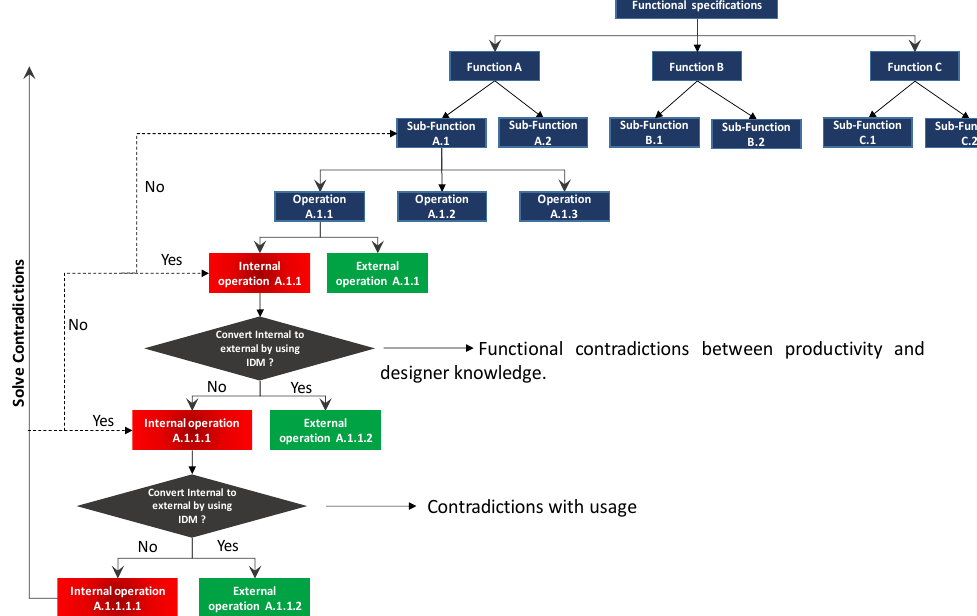
Figure 3. Resolving contradictions due to the conversion of internal operation in external